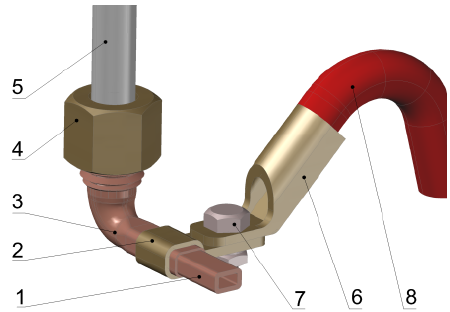
Figure 2. Fitting of the EMM cooling system: 1. tubular coil conductor; 2. a cable tie of the current lead; 3. fitting case; 4. coupling nut; 5. COC pipeline; 6. cable terminal; 7. bolt; and 8. flexible current conductor.